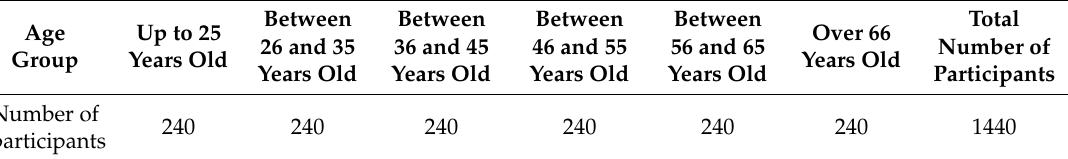
Table 3. Distribution of participants by age